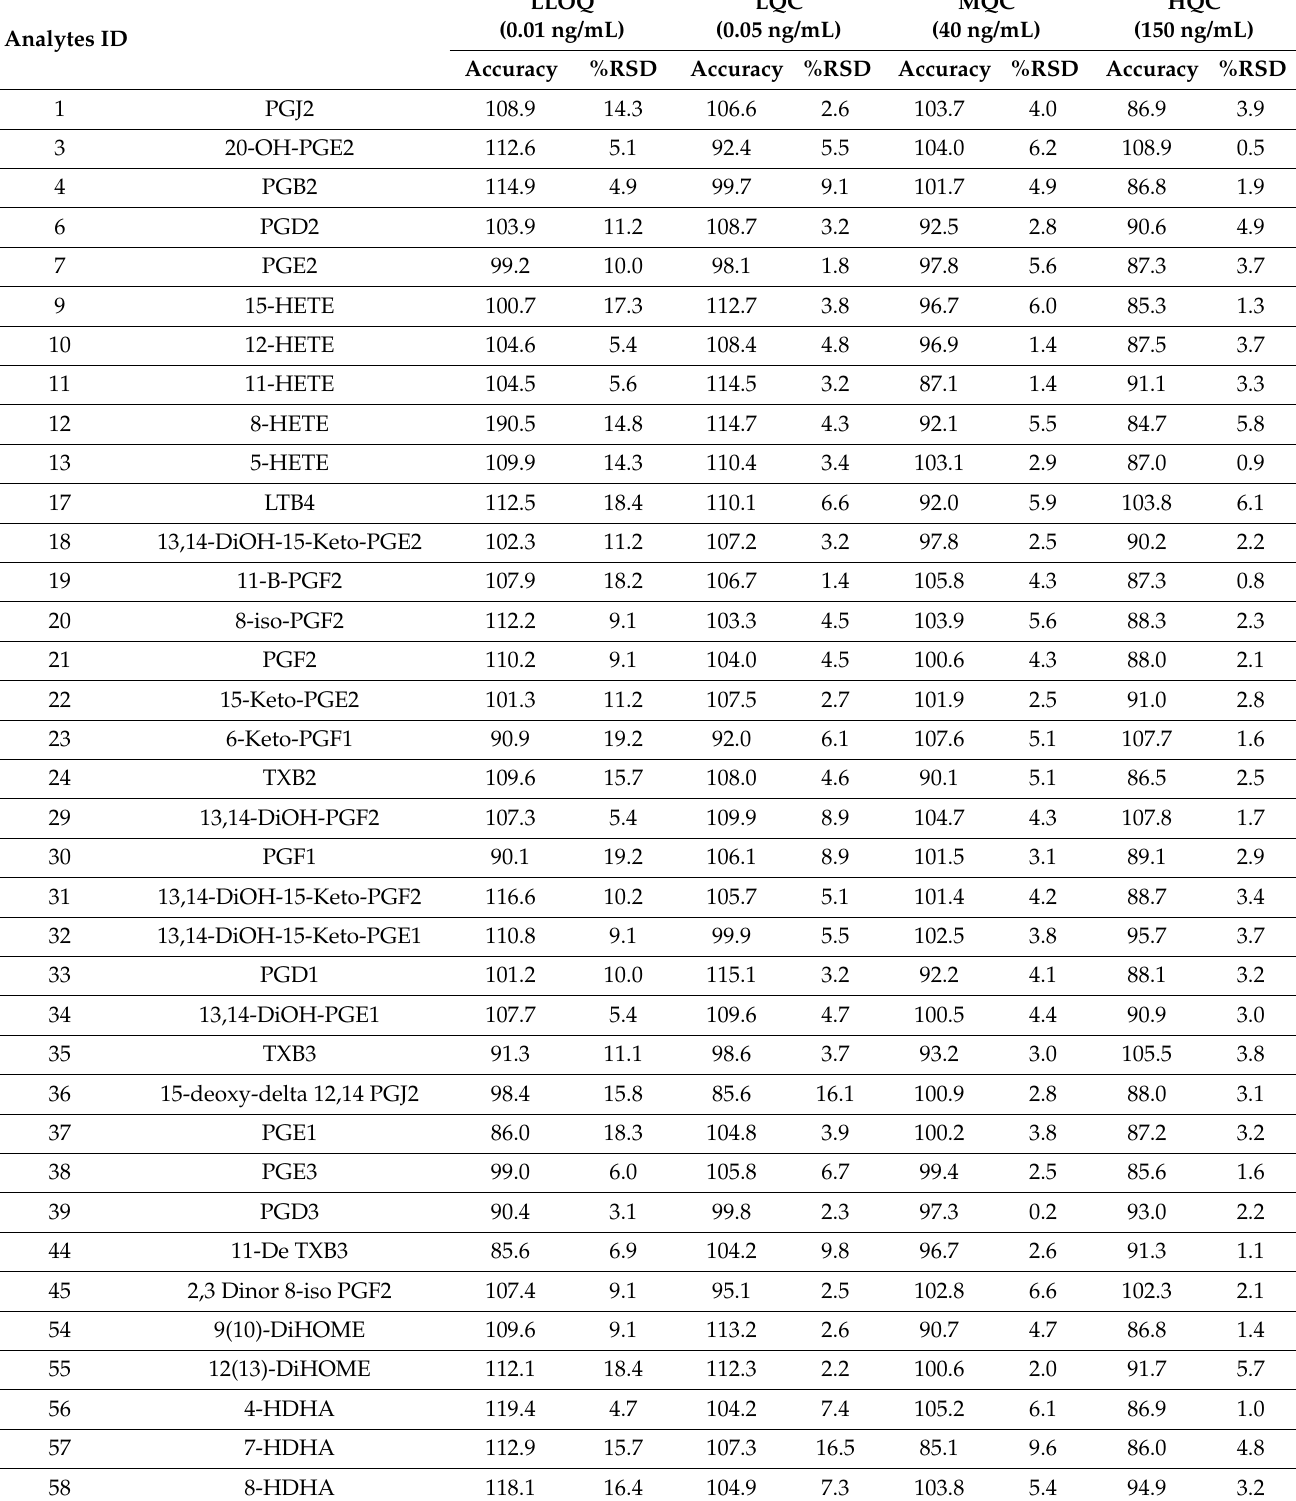
Table 2. Accuracy and precision of eicosanoids in the charcoalated surrogate